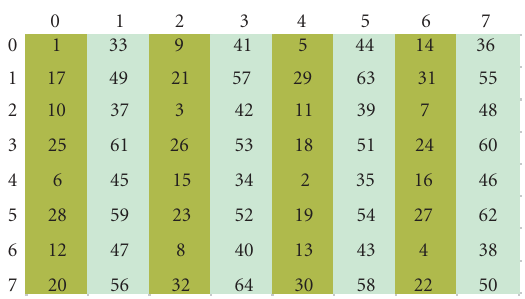
Figure 5: Computation order of coe ffi